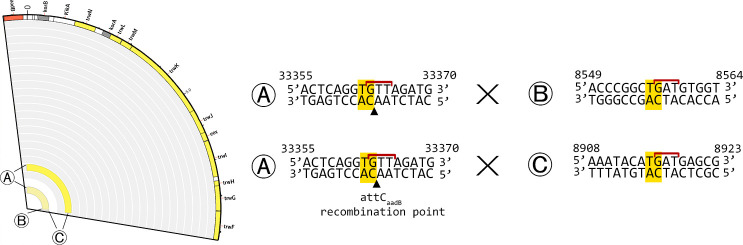
Re-arrangements in the plasmid backbone of the WT populations at ×1024 MIC.Left: Re-arrangements in the plasmid backbone of the WT populations at ×1024 MIC. Each junction site is indicated by a letter. Right: junction sequences for each re-arrangement. The junction site is indicated in yellow (as the crossover point is unclear due to sequence homology between each junction, the entire homology is highlighted). The GNT integron secondary motif is indicated by a red line. The recombination point of the aadB attC site is indicated by a black arrow.